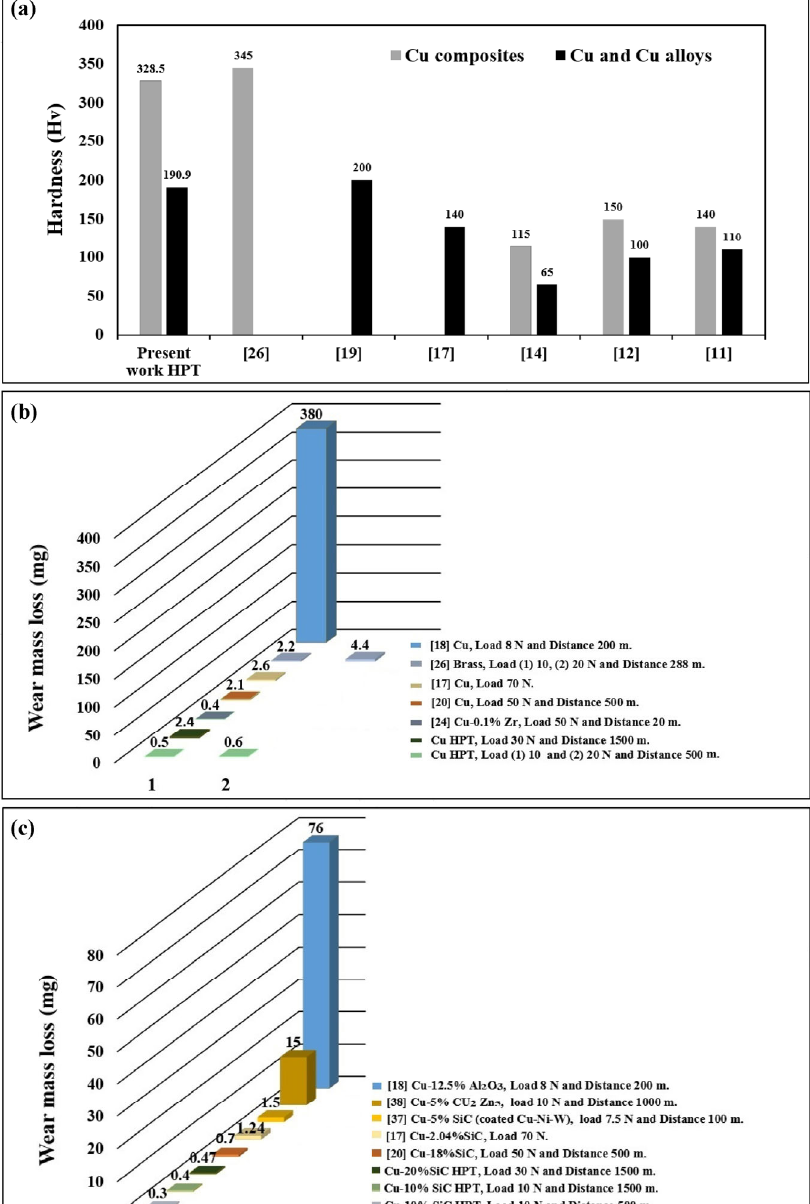
Fig. 6 Comparison between (a) hardness and wear mass loss of HPTed (b) Cu and (c) Cu-SiC samples with previous works concerned with fabrication of UFG and nanosize Cu and Cu composites